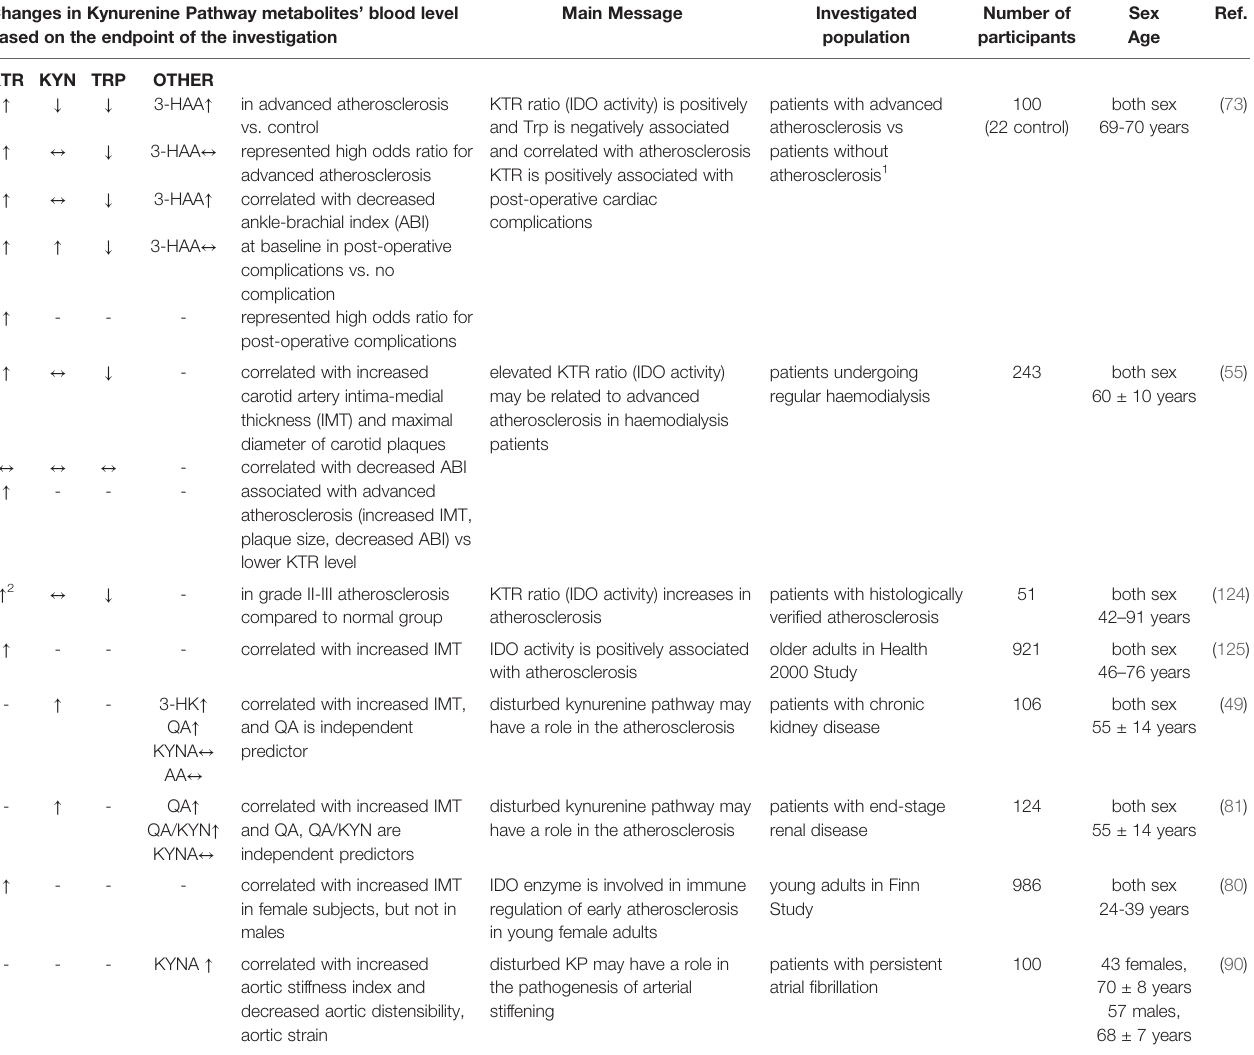
TABLE 3 | Kynurenine pathway (KP) metabolites: markers of atherosclerosis. Changes in Kynurenine Pathway metabolites ’ blood level based on the endpoint of the